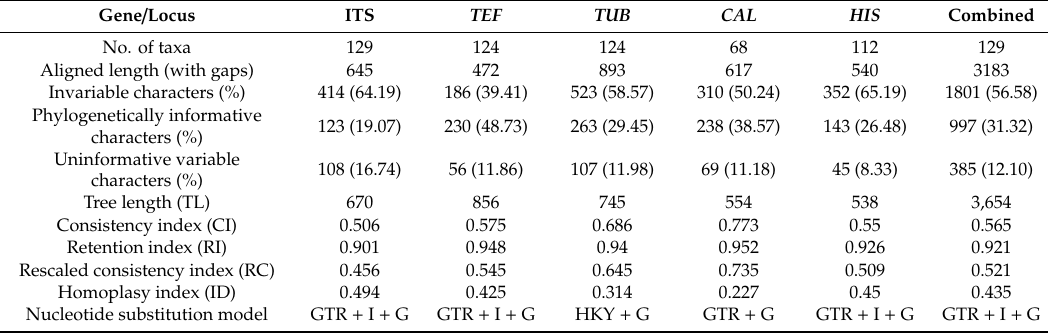
Table 2. Comparison of alignment properties in parsimony analyses of gene / locus and nucleotide substitution models used in phylogenetic